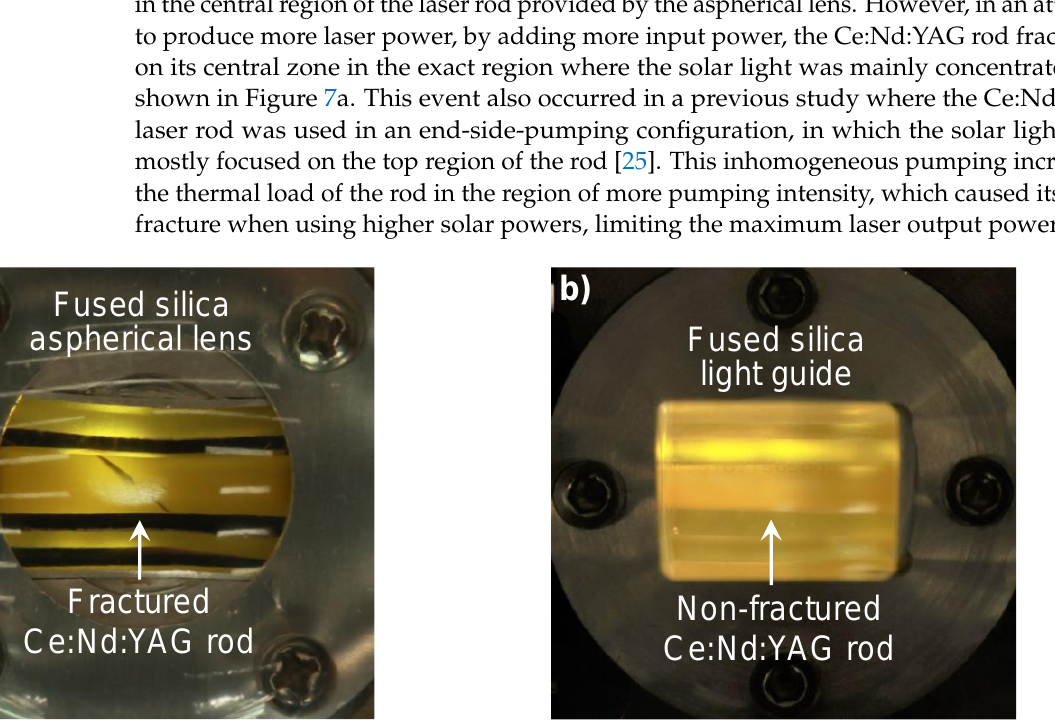
Figure 7. Photograph of the Ce:Nd:YAG laser rods on the laser heads with the fused liquid fused liquid aspheric lens ( a ) and rectangular light guide ( b ) after the solar laser experiments. The fracture on the Ce:Nd:YAG laser rod using the aspheric lens is visible on its central region.